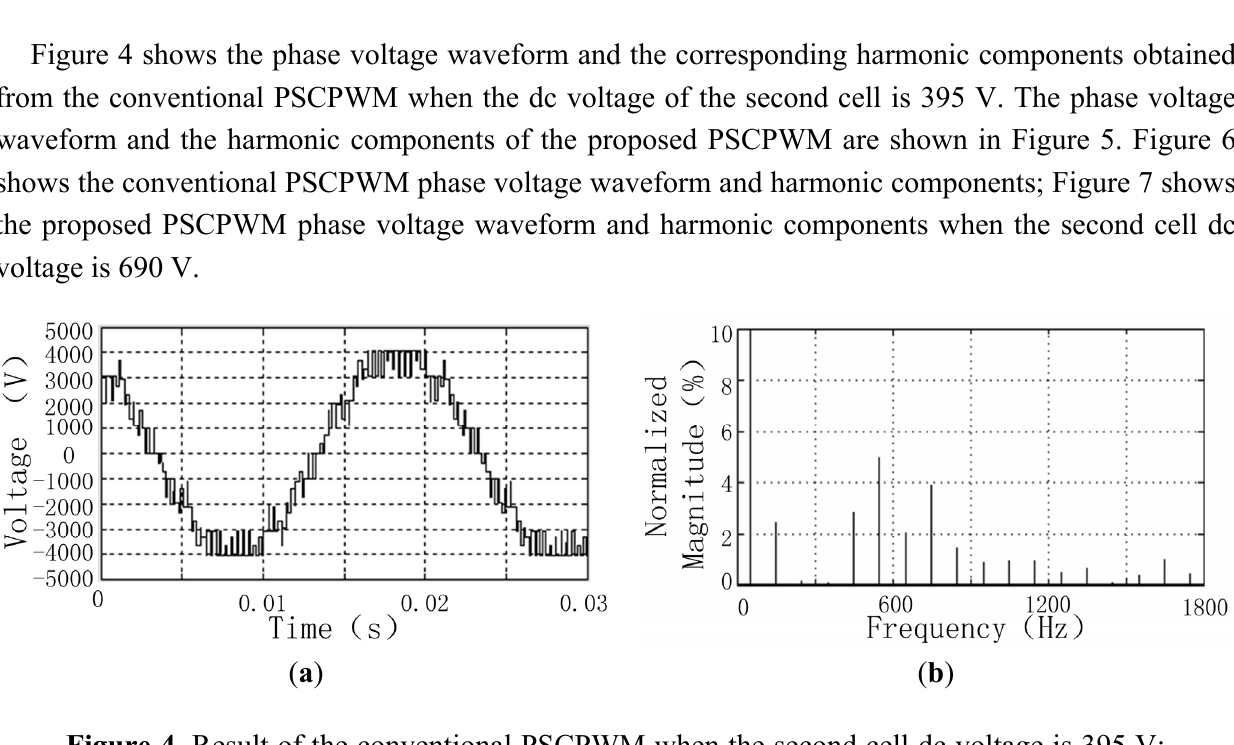
Figure 4. Result of the conventional PSCPWM when the second cell dc voltage is 395 V: ( a ) output voltage waveform; and ( b ) harmonics.